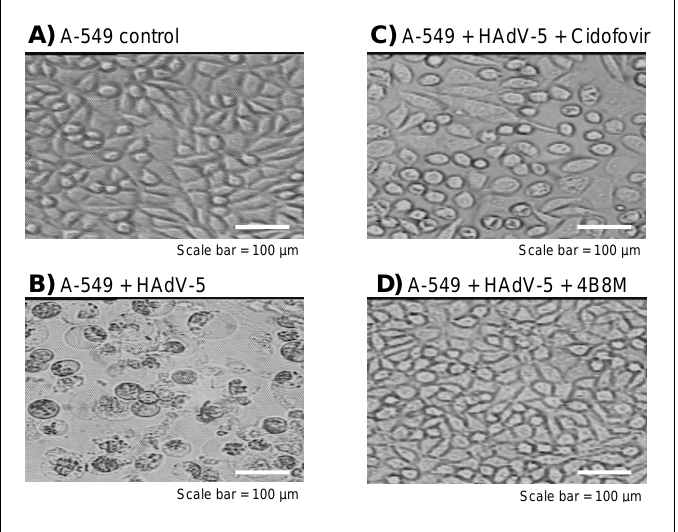
Scale bar = 100 µm Figure 5. Antiviral activity of 4B8M against HAdV-5 and its morphological changes in the A-549 cells examined with phase contrast microscopy. The photographs show 48 h cultures of A-549 cells infected with HAdV-5 virus (magnification 300×); ( A ) photograph shows a normal appearance of the control culture of A-549 cells in the culture medium, ( B – D ) photographs show cells pretreated with the virus: ( B ) HAdV-5 negative control; after 48 h infection with HAdV-5, the A-549 cells showed some morphological changes, including loss of monolayer integrity, lyses, granulation, vacuolization in the cytoplasm, ( C ) A-549 cells infected with HAdV-5 in the presence of Cidofovir (20 µ g/mL), ( D ) A-549 cells after 48 h co-incubation with HAdV-5 and 4B8M (25 µ